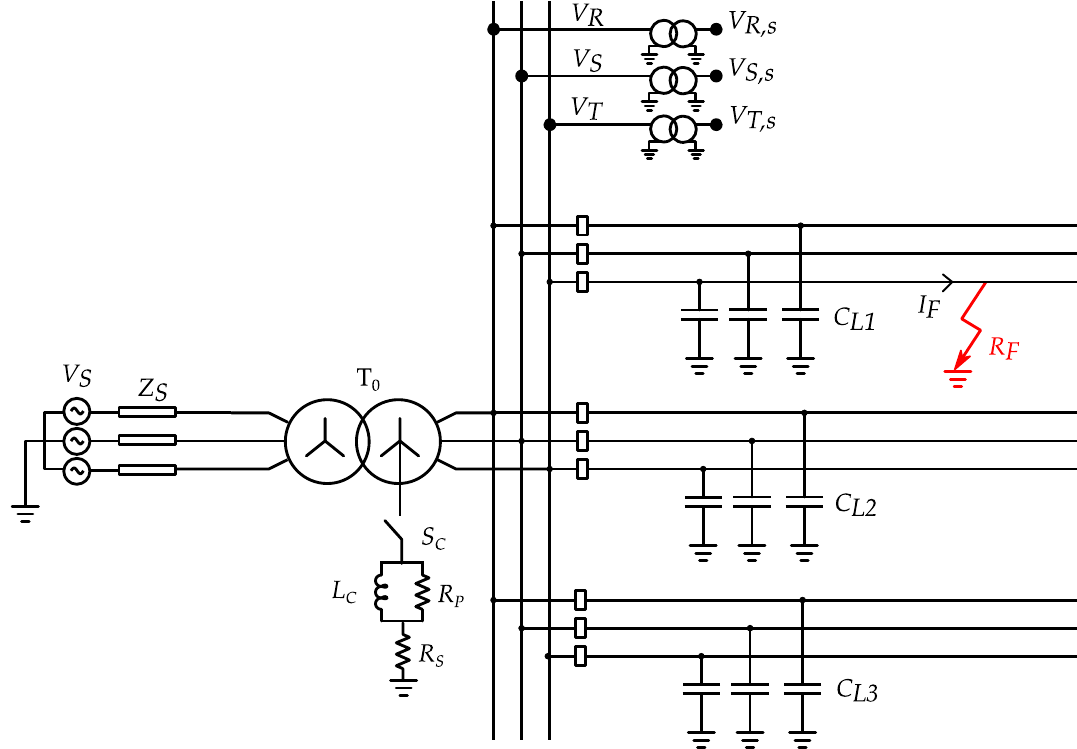
Figure 2. Simplified schematic simulation circuit .